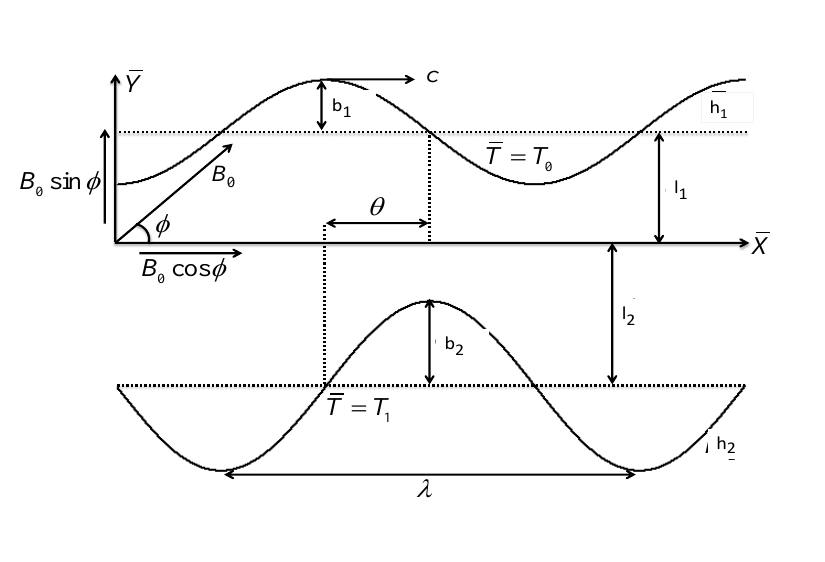
Figure 1. Geometry of the physical